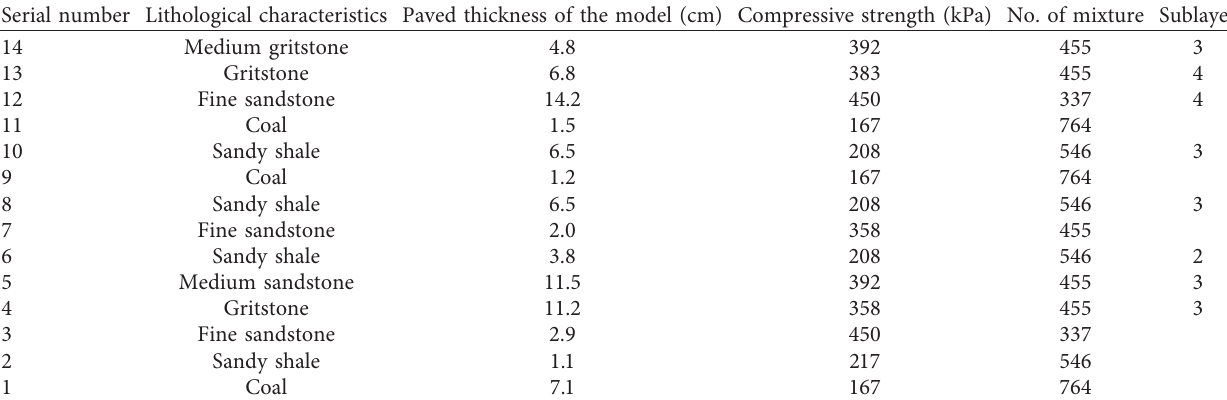
Table 2: Physical and mechanical parameters of coal strata with large mining height.